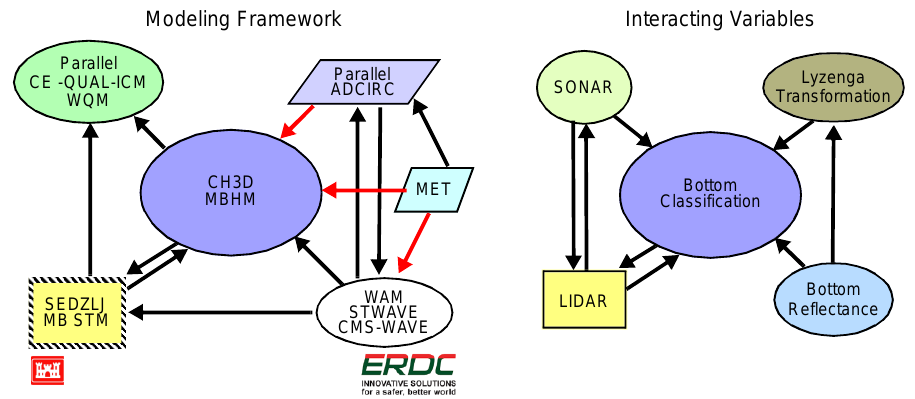
Figure 4. ERDC-EL Hydrodynamic Model GSMB Components ( left ): SEDZLJ (sediment transport model), ADCIRC (hydrodynamics model), WAM (wave model), CH3D-MB-HM (regional scale model), MET (meteorological input model) and CE-QUAL-ICM WQM (water quality model). Interacting variables in the LiDAR / MSS portion of investigations ( right ): SONAR aids LiDAR which helps bottom classification. Bottom reflectance studies (MSS) utilize Lyzenga method for depth-correction.